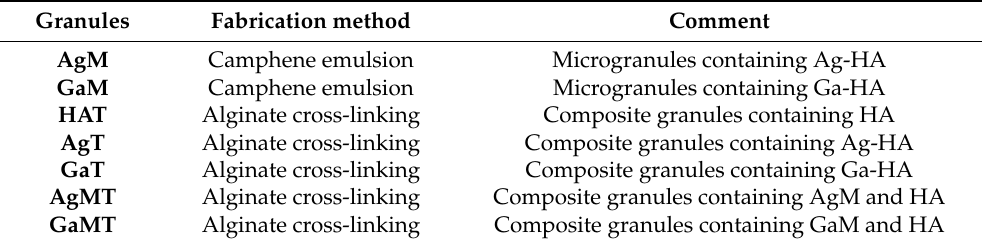
Table 6. List of all the obtained granules from Ag-HA or Ga-HA